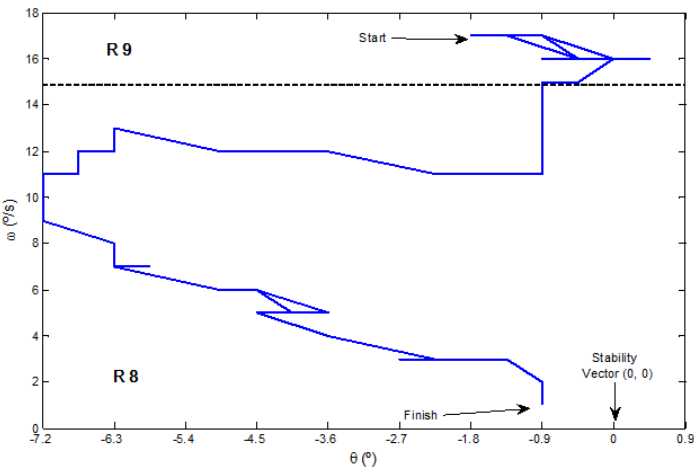
Figure 11. Results of linguistic trajectories in a real left knee flexion exercise.